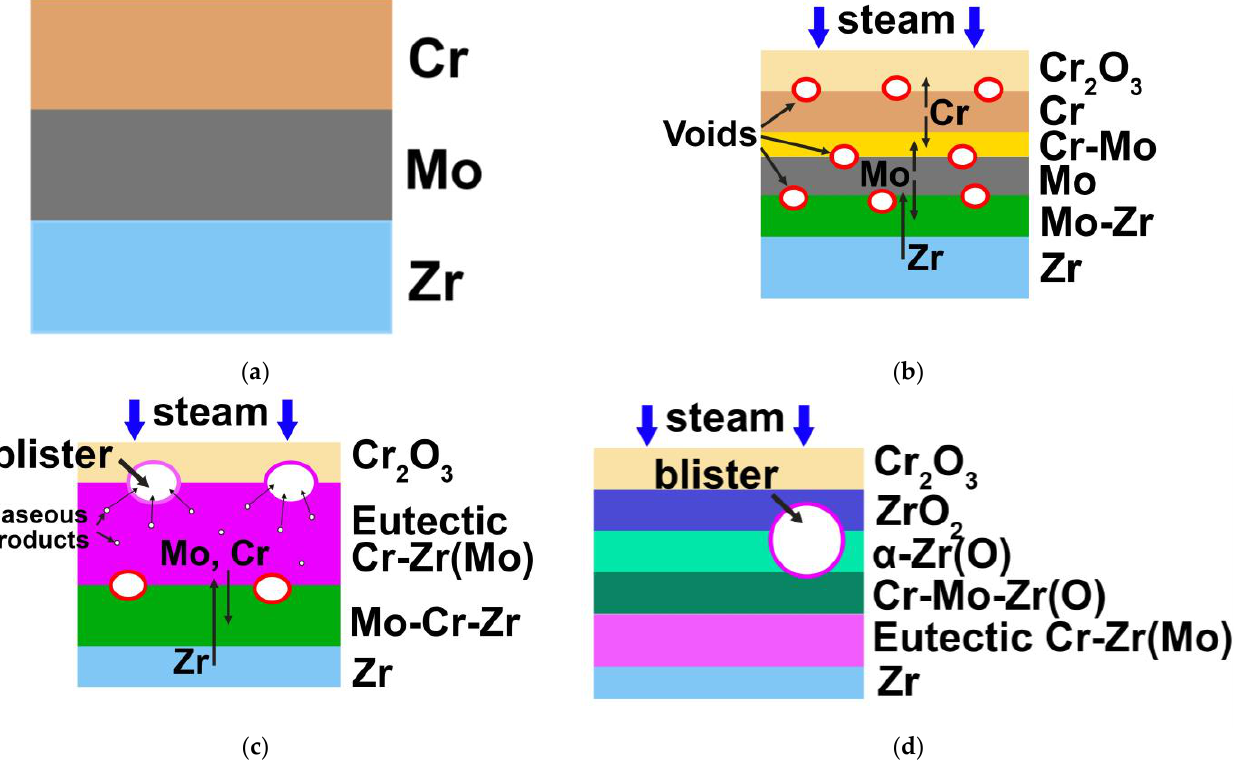
Figure 10. Schematic diagram of the oxidation process for the Cr/Mo-coated Zr-1Nb alloy at 1400 °C: initial state ( a ); stage I ( b ); stage II ( c ); stage III ( d ). initial state ( a ); stage I ( b ); stage II ( c ); stage III ( d